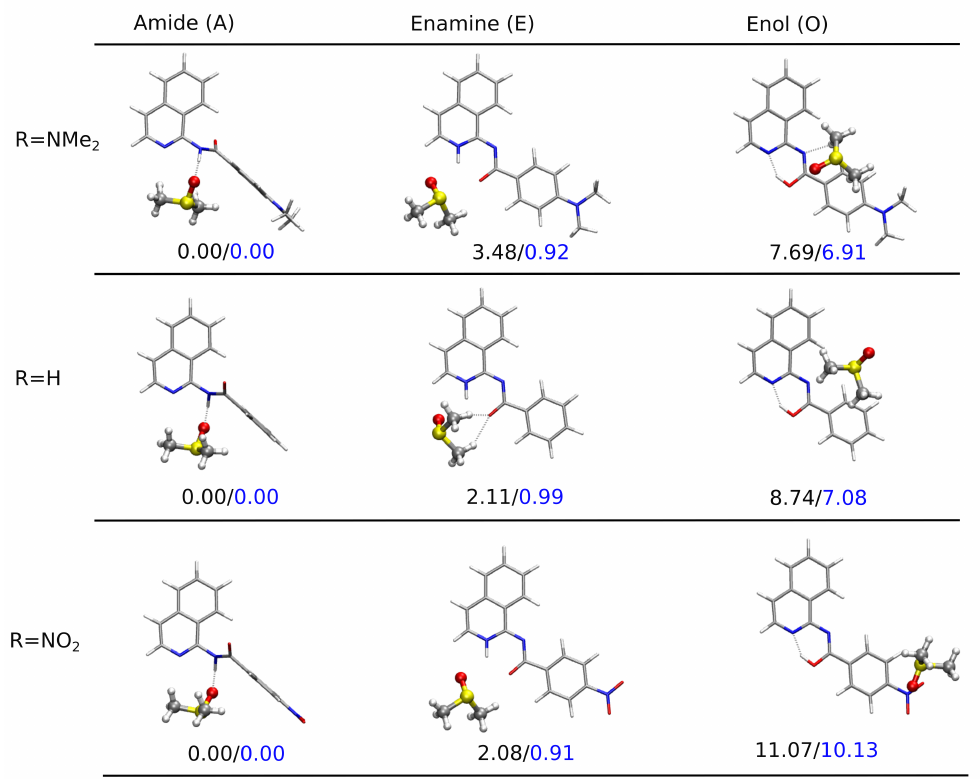
Figure 6. Optimized structures for the tautomeric forms of NMe 2 , H, and NO 2 -substituted deriva- tives ( 1 , 5 ,p and 10 ) together with the relative Gibbs free energies in kcal/mol ( ω B97X-D/def2- TZVP/PCM(DMSO) calculations for the complexes with the explicitly included one solvent molecule). The solute–solvent complex for the enamine tautomer of the unsubstituted R=H system 5 featured a different placement of DMSO molecule with respect to the N-H · · · O moiety than 1 and 10 . The configuration analogous to 1 and 10 was about 1.3 kcal/mol higher in energy. For the enol tautomers, the potential energy surface is significantly flatter with a huge number of shallow minima arising from a multitude of various positions of DMSO over or under the enol molecule plane in the case of all the derivatives; thus, a direct comparison of the different derivatives may not be straightforward, but qualitative conclusions can be